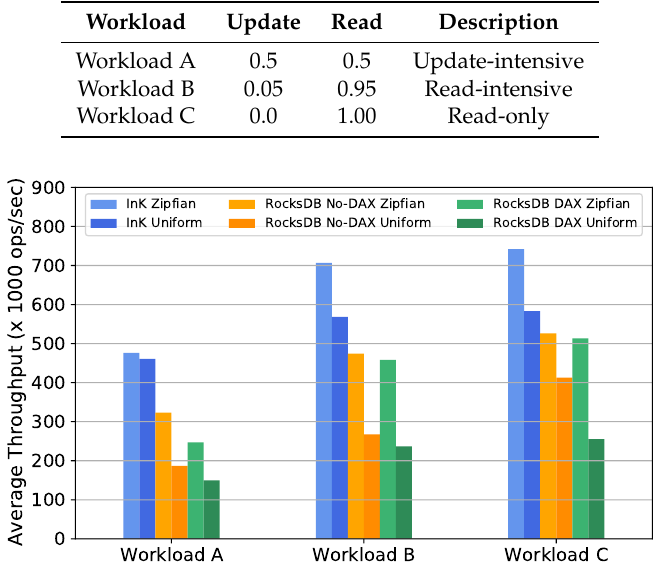
Figure 10. Performance comparison of InK and